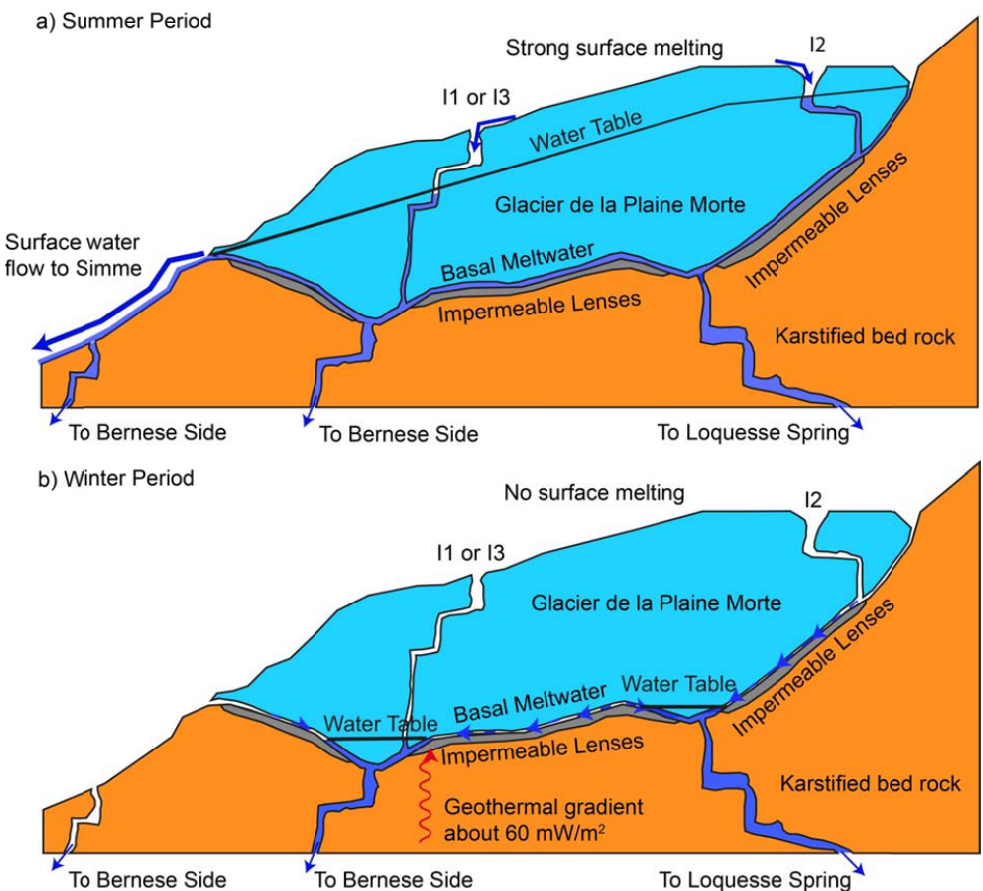
Fig. 11. Schematic sequence of drainage of meltwater in subglacial, karstic and surface flow paths during (a) summer season and (b) winter